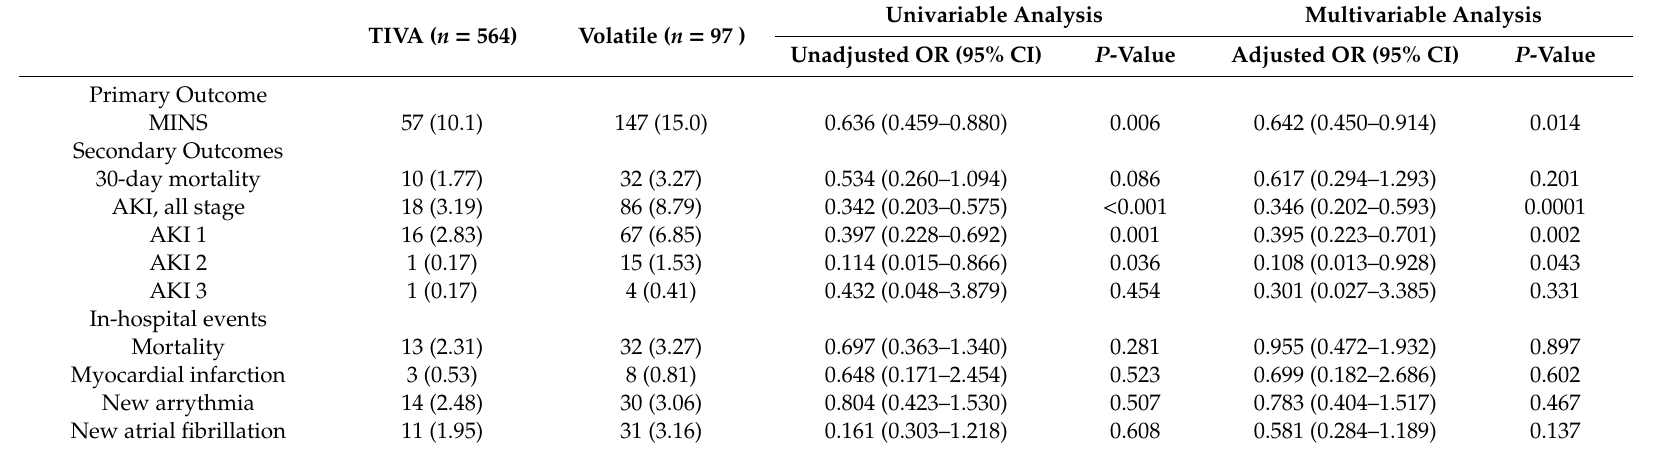
Table 3. Clinical outcomes comparing TIVA versus volatile groups in matched